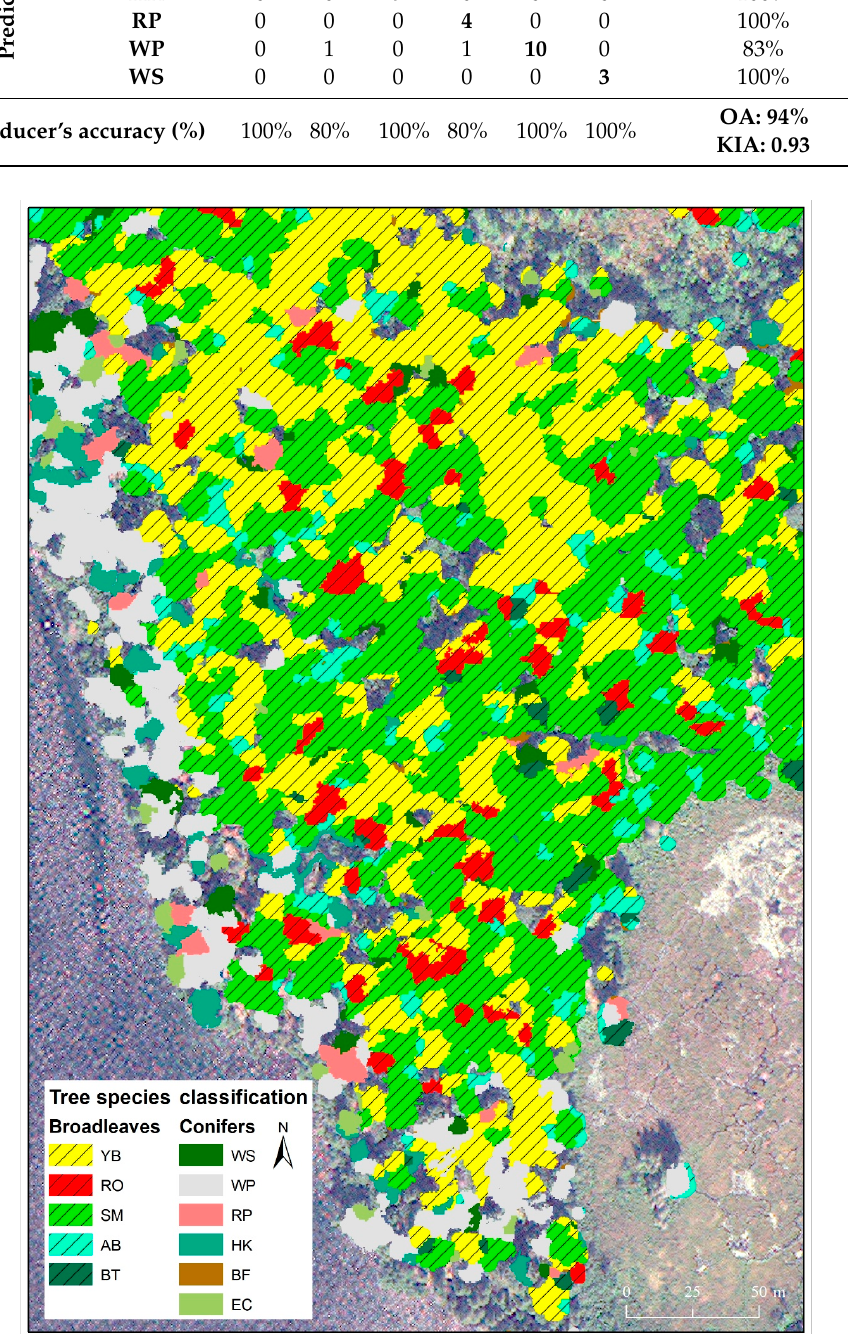
Figure 7. Tree species classification map. The background image displays WorldView-3 in true colors. The species’ abbreviations are described in Table 2.